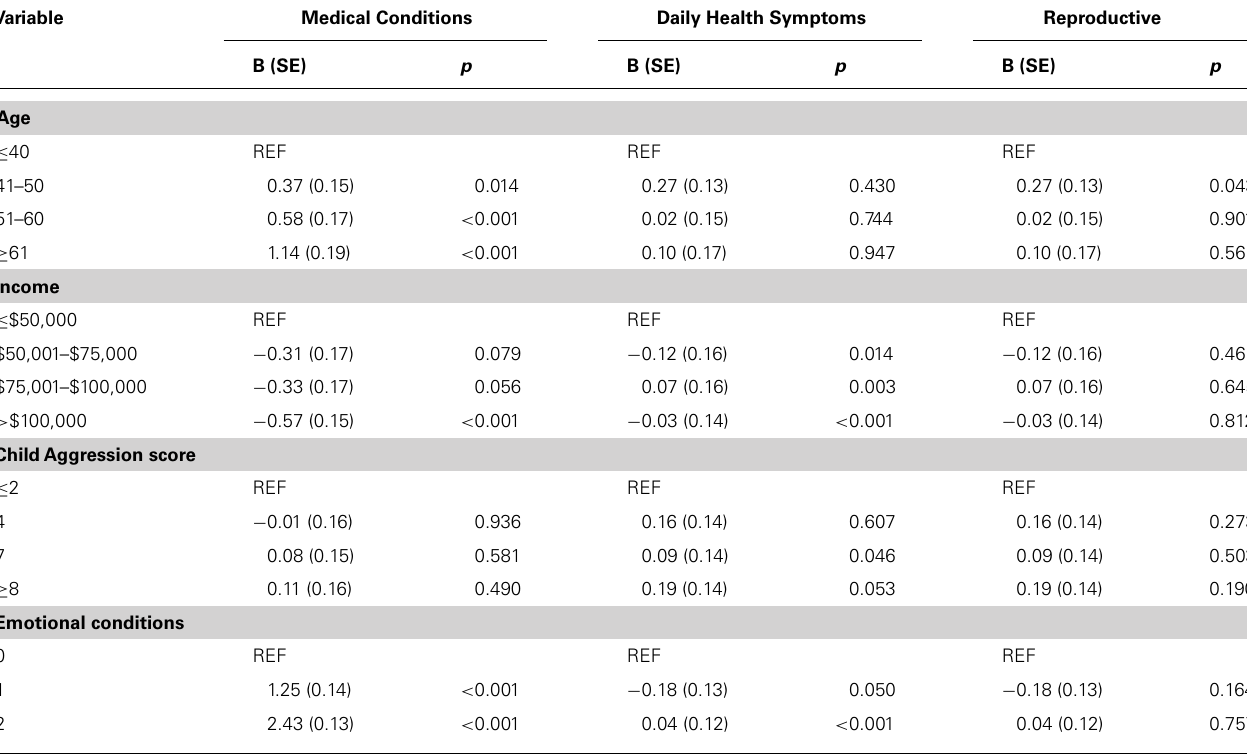
Table 2 | Regression models of health and reproductive outcomes. Variable